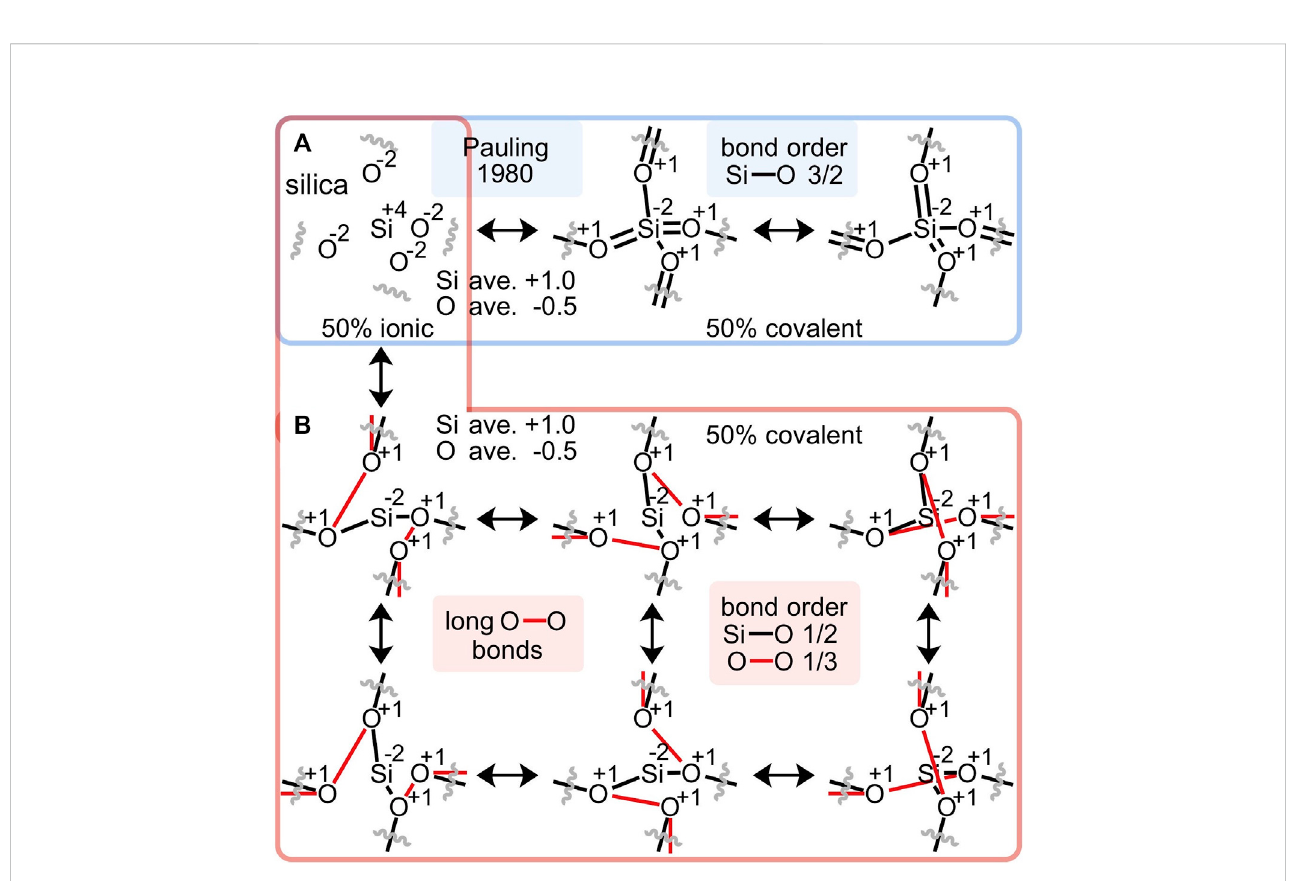
FIGURE 2 An alternative to Pauling ’ s resonance scheme for silica (A) proposes long oxygen-oxygen bonds, ranging from 2.61 to 2.64 Å (B) . This alternative conformstoPauling ’ s50%ionic/50%covalentapportionment,enliststhesameaverageatomicchargesandoxidationstates,avoidsunwarrantedSi-Odouble bonds, suggests Si-O bond orders of 1/2 and geminal O-O bond orders of 1/3 and thus, employs equal numbers of Si-O and O-O valence electrons.